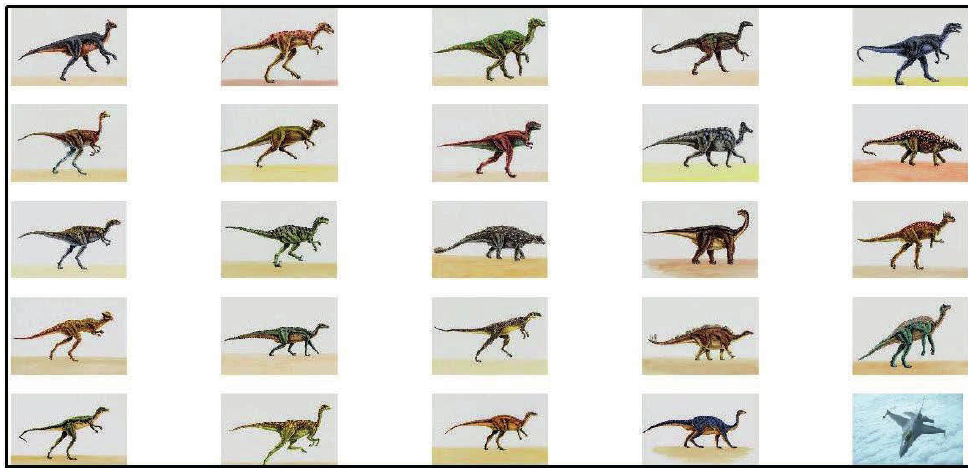
Fig. 15. Dinosaur images retrieved at the first stage of Framework-2